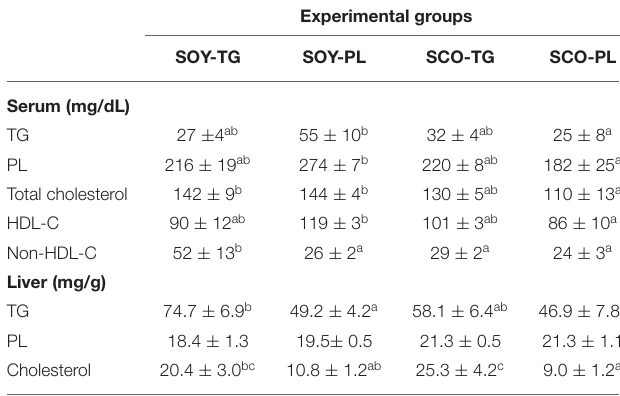
Experimental groups SCO-TG SCO-PL